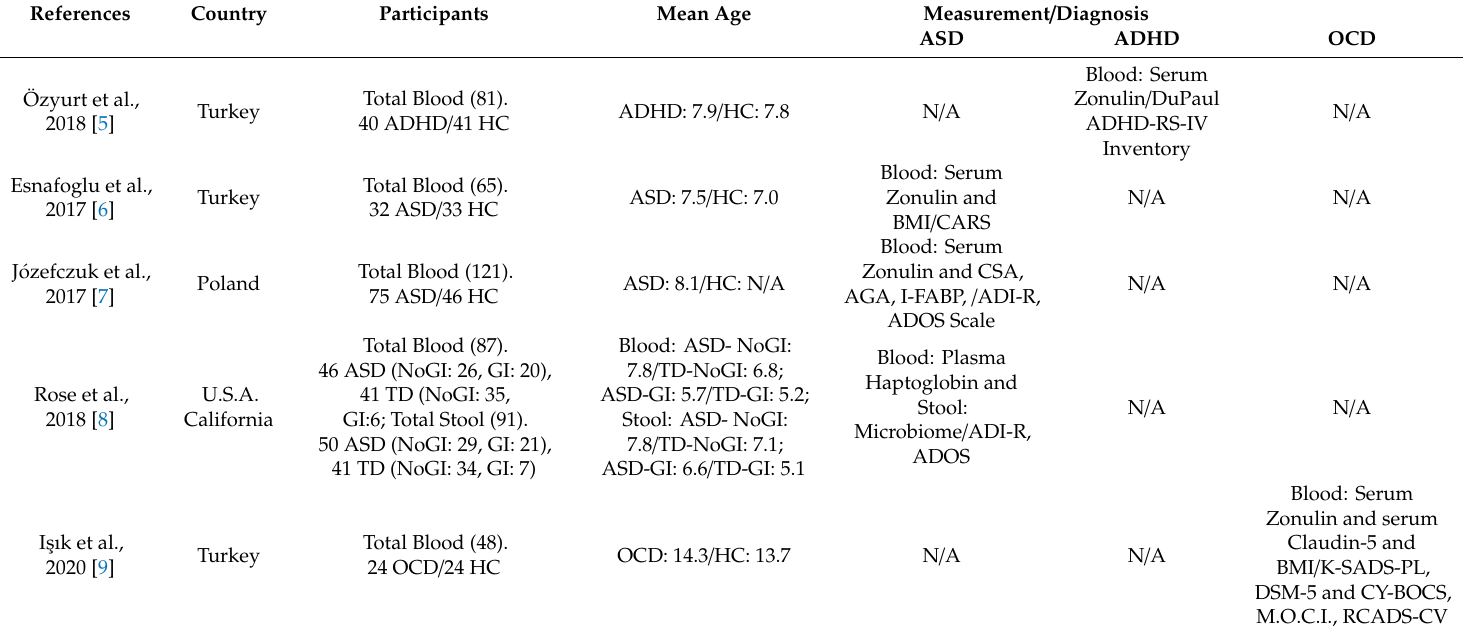
Table 3. Summary of the characteristics of the included case-control